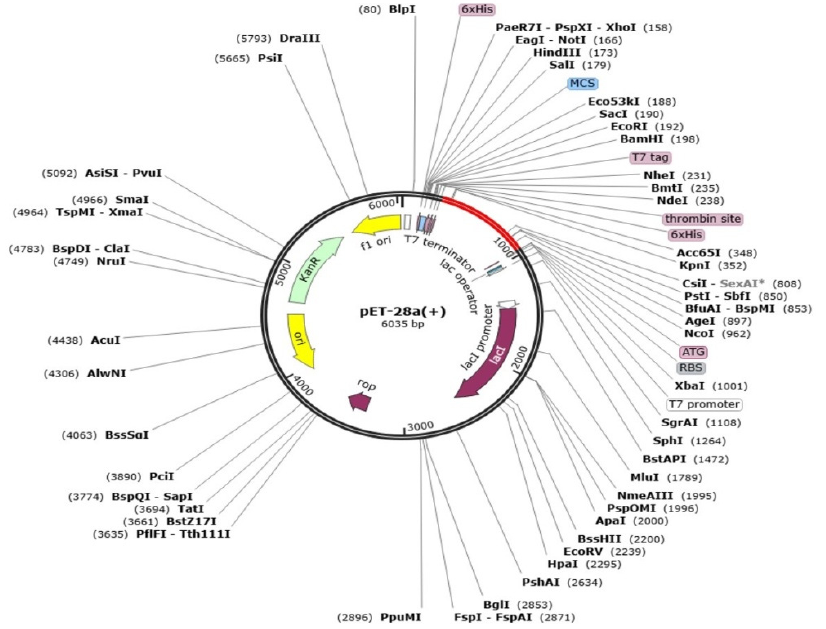
Figure 7. Cloned vaccine sequence (shown in red) into pET-28a(+) expression vector (shown in black).